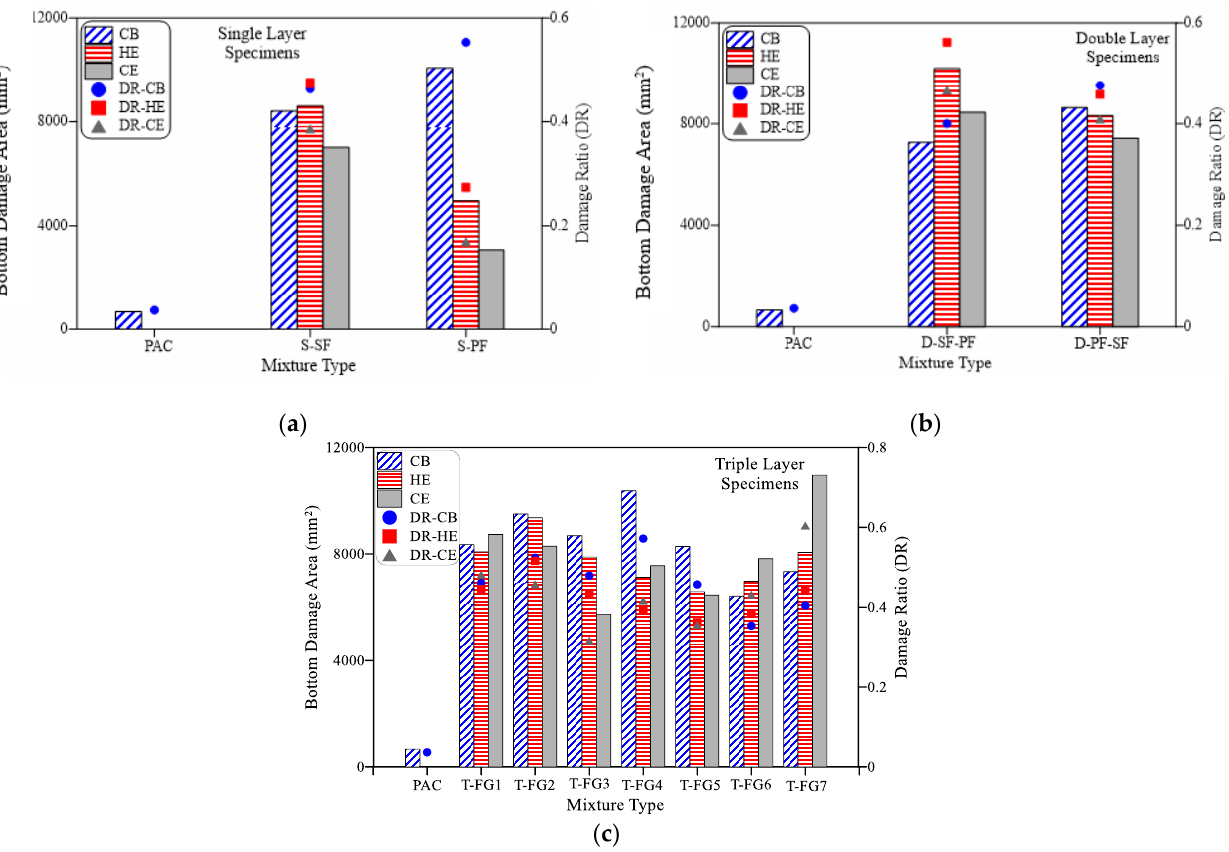
Figure 14. Bottom area of the three groups of specimens FPAFC ( a ) Single layer, ( b ) Double layer and ( c ) Triple layer.